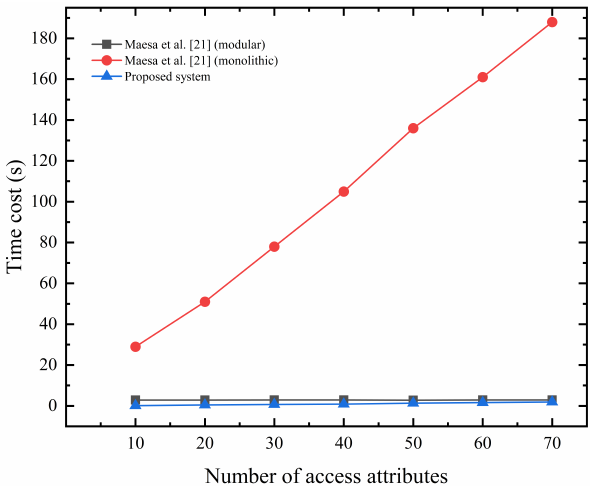
Figure 8. Zero-knowledge proof generation time (s) off the chain of Maesa et al.’s system [21] and ours.